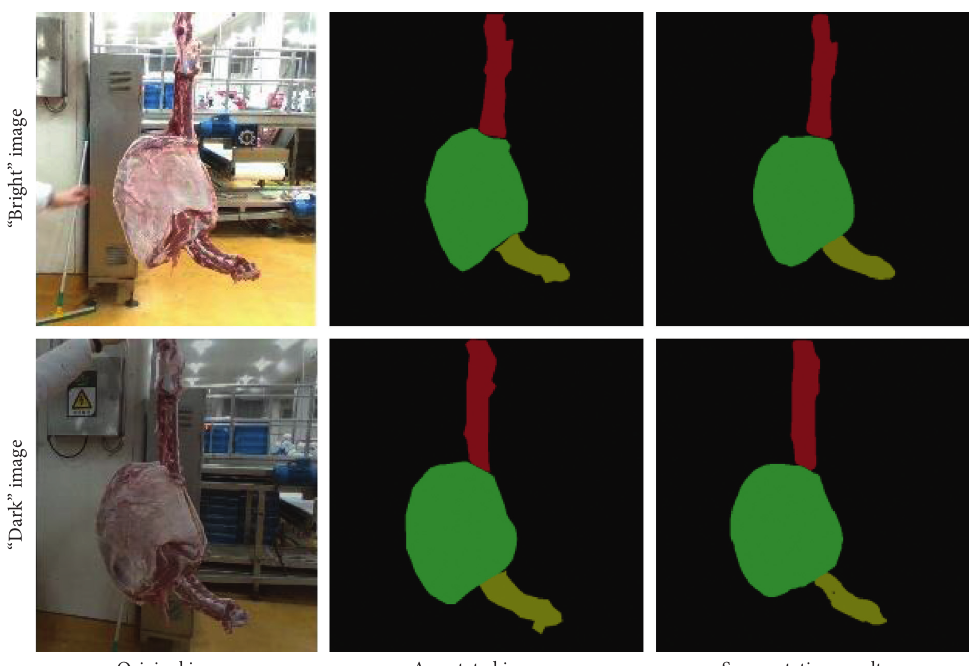
Figure 9: Examples of generalization test results.